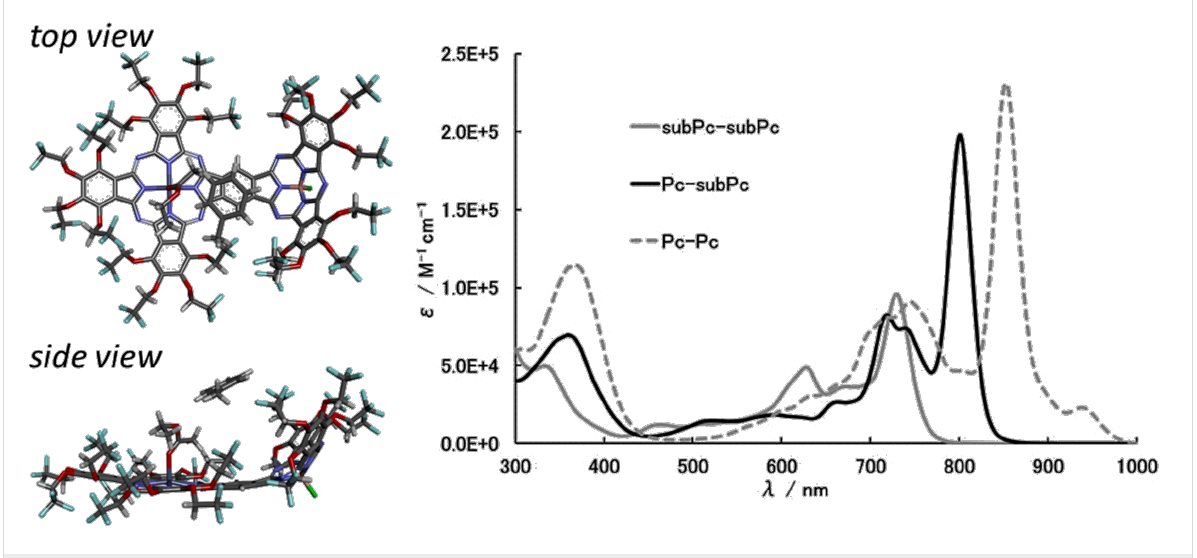
Figure 10: X-ray crystallography of Pc-subPc (left) and UV–vis spectra of benzene-fused dimers.